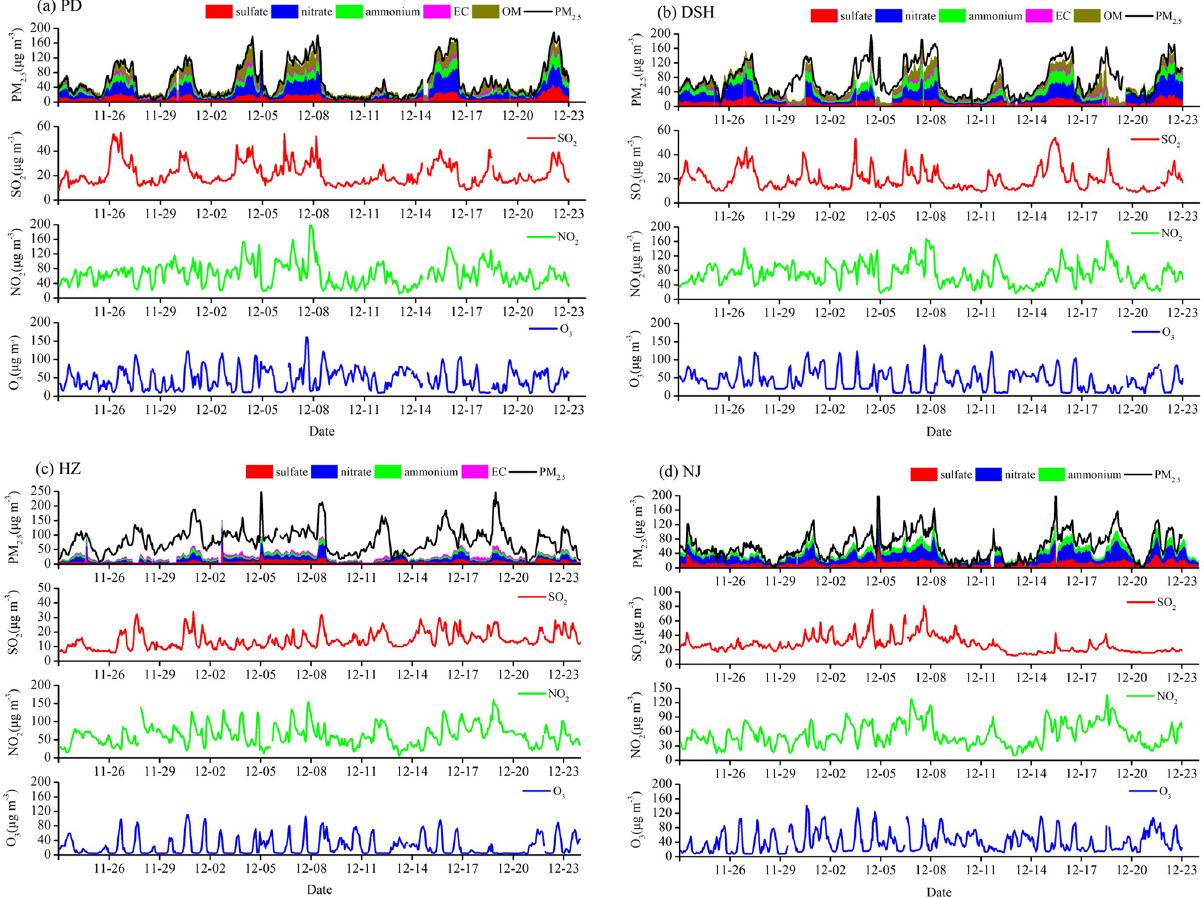
Figure 5. Same as Fig. 4 but for Period